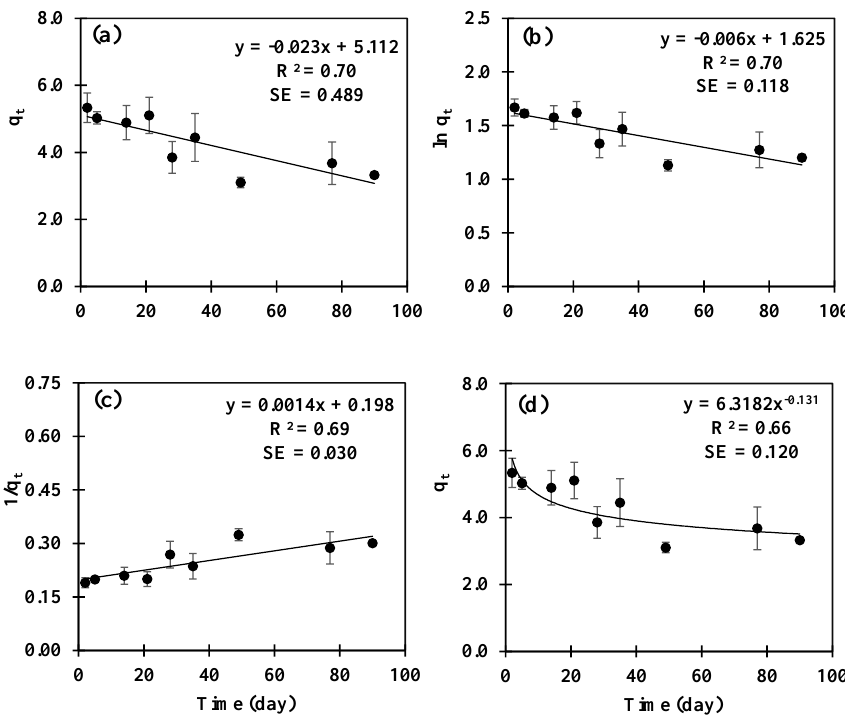
Figure 2. Diethylenetriaminepentaacetic acid (DTPA)-extractable Zn over the long term (90 days) in the chelated system fitted to (a) zero- order, (b) first-order, (c) second-order, and (d) power-function models ( q t is the amount remaining at time t (mgkg − 1 ); error bars are for standard errors computed from six data points). Table 3. Regression equation and coefficient of determination ( R 2 ) of changes in available Zn with respect to other micronutrient elements (Cu, Fe, and Zn) in the non-chelated and chelated systems of the studied semi-arid alkaline soils of the Southern High Plains, USA ( n =